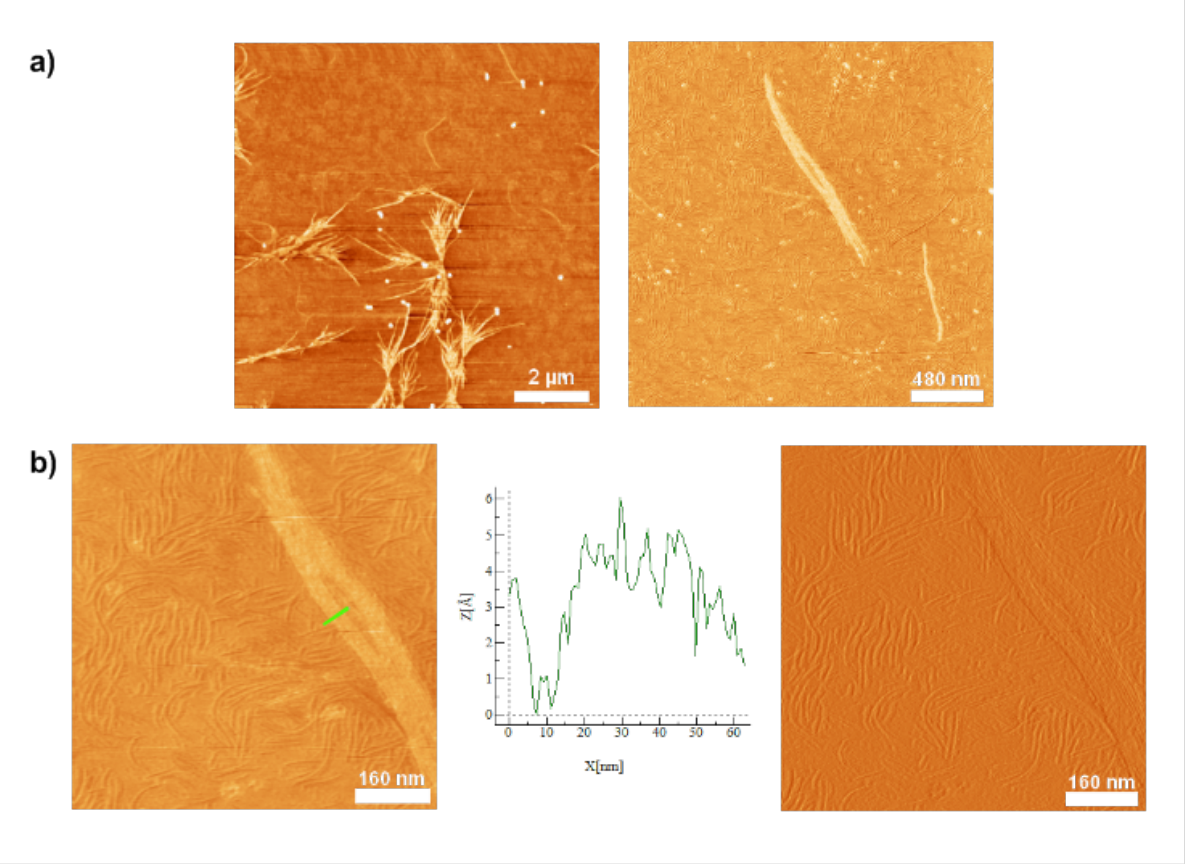
Figure 7: AFM height and amplitude images of fully switched PEO–peptide–quaterthiophene 6 on mica [23]. a) left: AFM height image obtained after 7 d; right: Zoom of single fiber; b) left: Height image of single fiber consisting of smaller filaments; middle: Cross section corresponding to the marked section in b), right: Amplitude image of b)